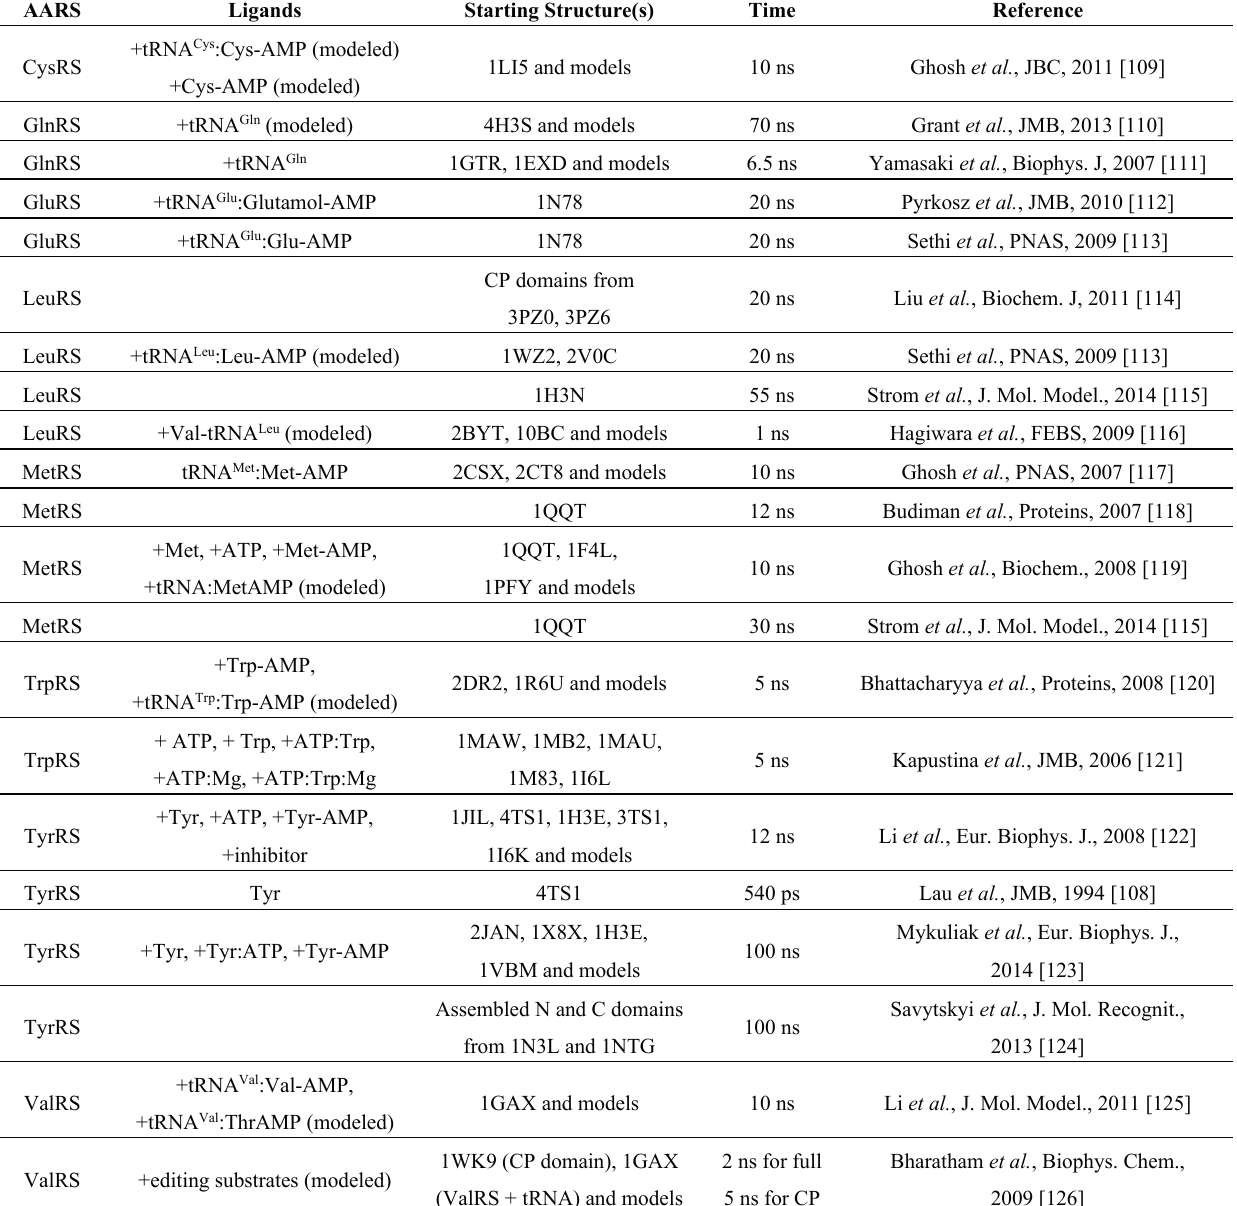
Table 2. MD Simulations of Class I